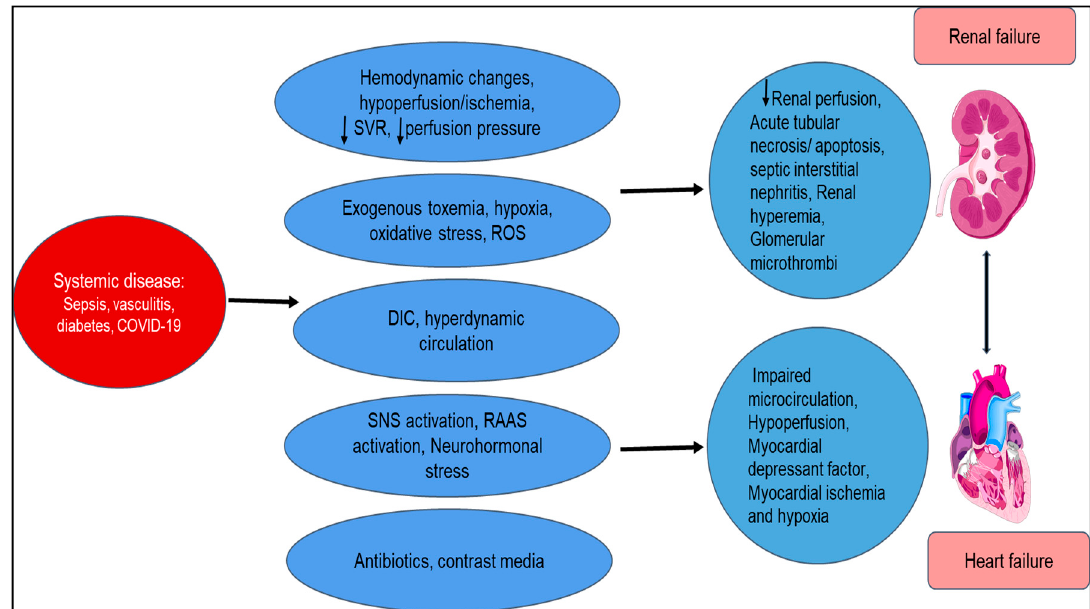
Figure 6. Summary of the pathophysiology of secondary cardiorenal syndrome (type 5): mechanism is characterized by combined cardiac and renal failure due to acute or chronic processes that cause hemodynamic instabilities, hypercoagulability, neurohormonal imbalances, and toxicity and hypoxia that cause poor renal perfusion, myocardial ischemia, and hypoxia. SVR= systemic vascular resistance; ROS= reactive oxygen species; DIC= disseminated intravascular coagulation; SNS= sympathetic nervous system; RAAS= renin–angiotensin–aldosterone system.